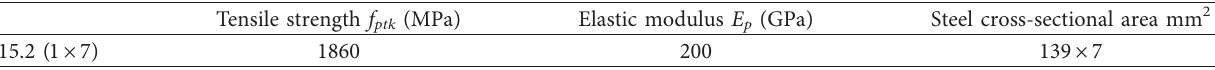
Table 4: Prestressed steel strand